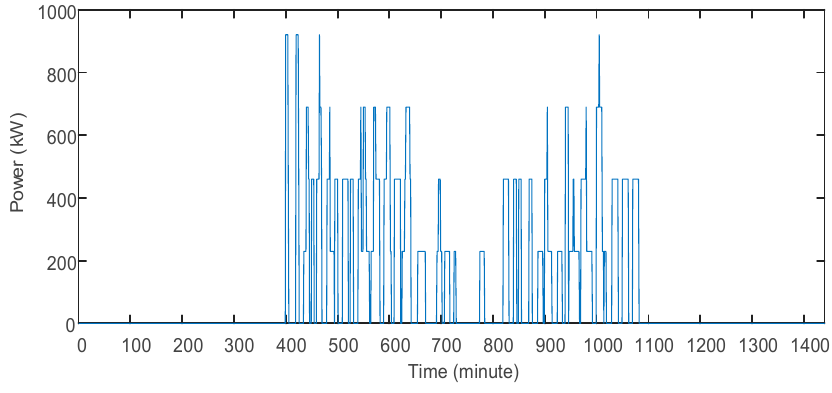
Figure 5. Optimized charging load in operating time.